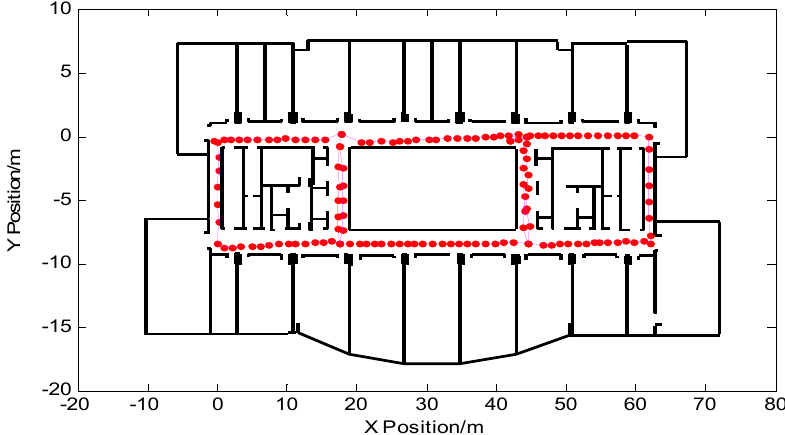
Figure 15. Pedestrian interior trajectory corrected based on this algorithm.